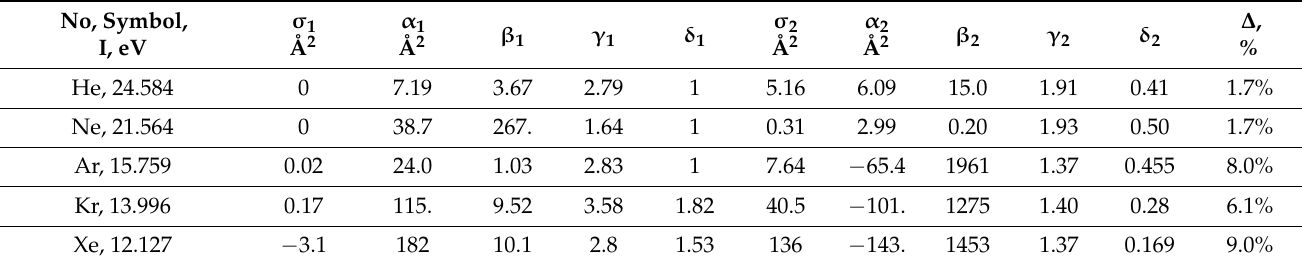
Table 1. Values of parameters for the approximation of transport cross sections of elastic collisions of electrons with noble gas